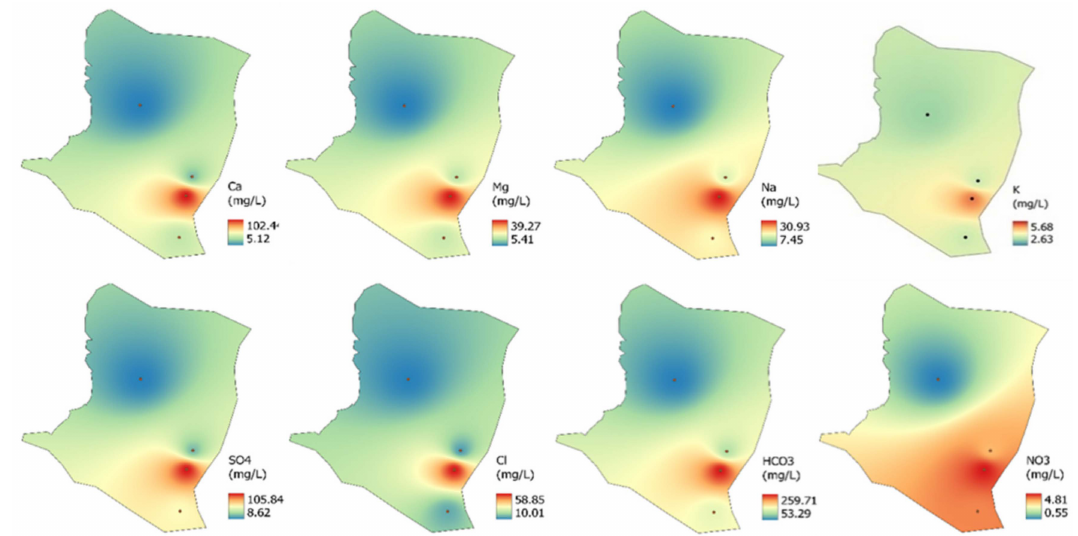
Figure 6. Spatial behavior of major ions in the Cuernavaca